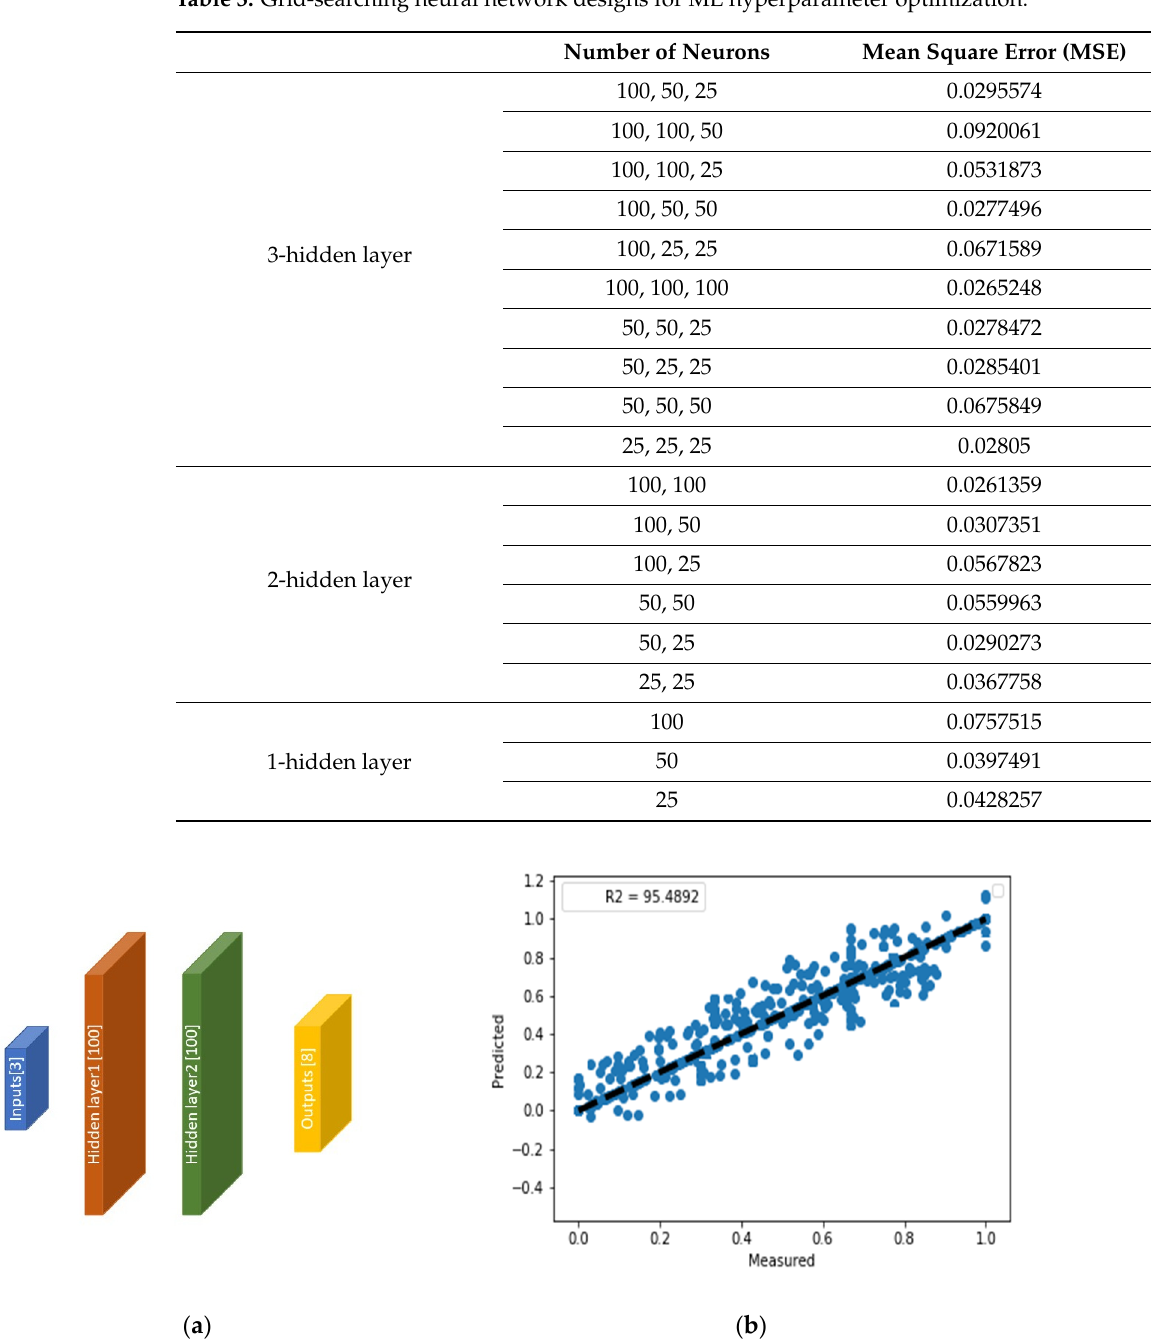
Figure 7. ( a ) The optimized fully connected neural network for direct structure–property links (surrogate of numerical homogenization) and ( b ) the network prediction’s regression plot (ordinate) with the ideal line of y = x